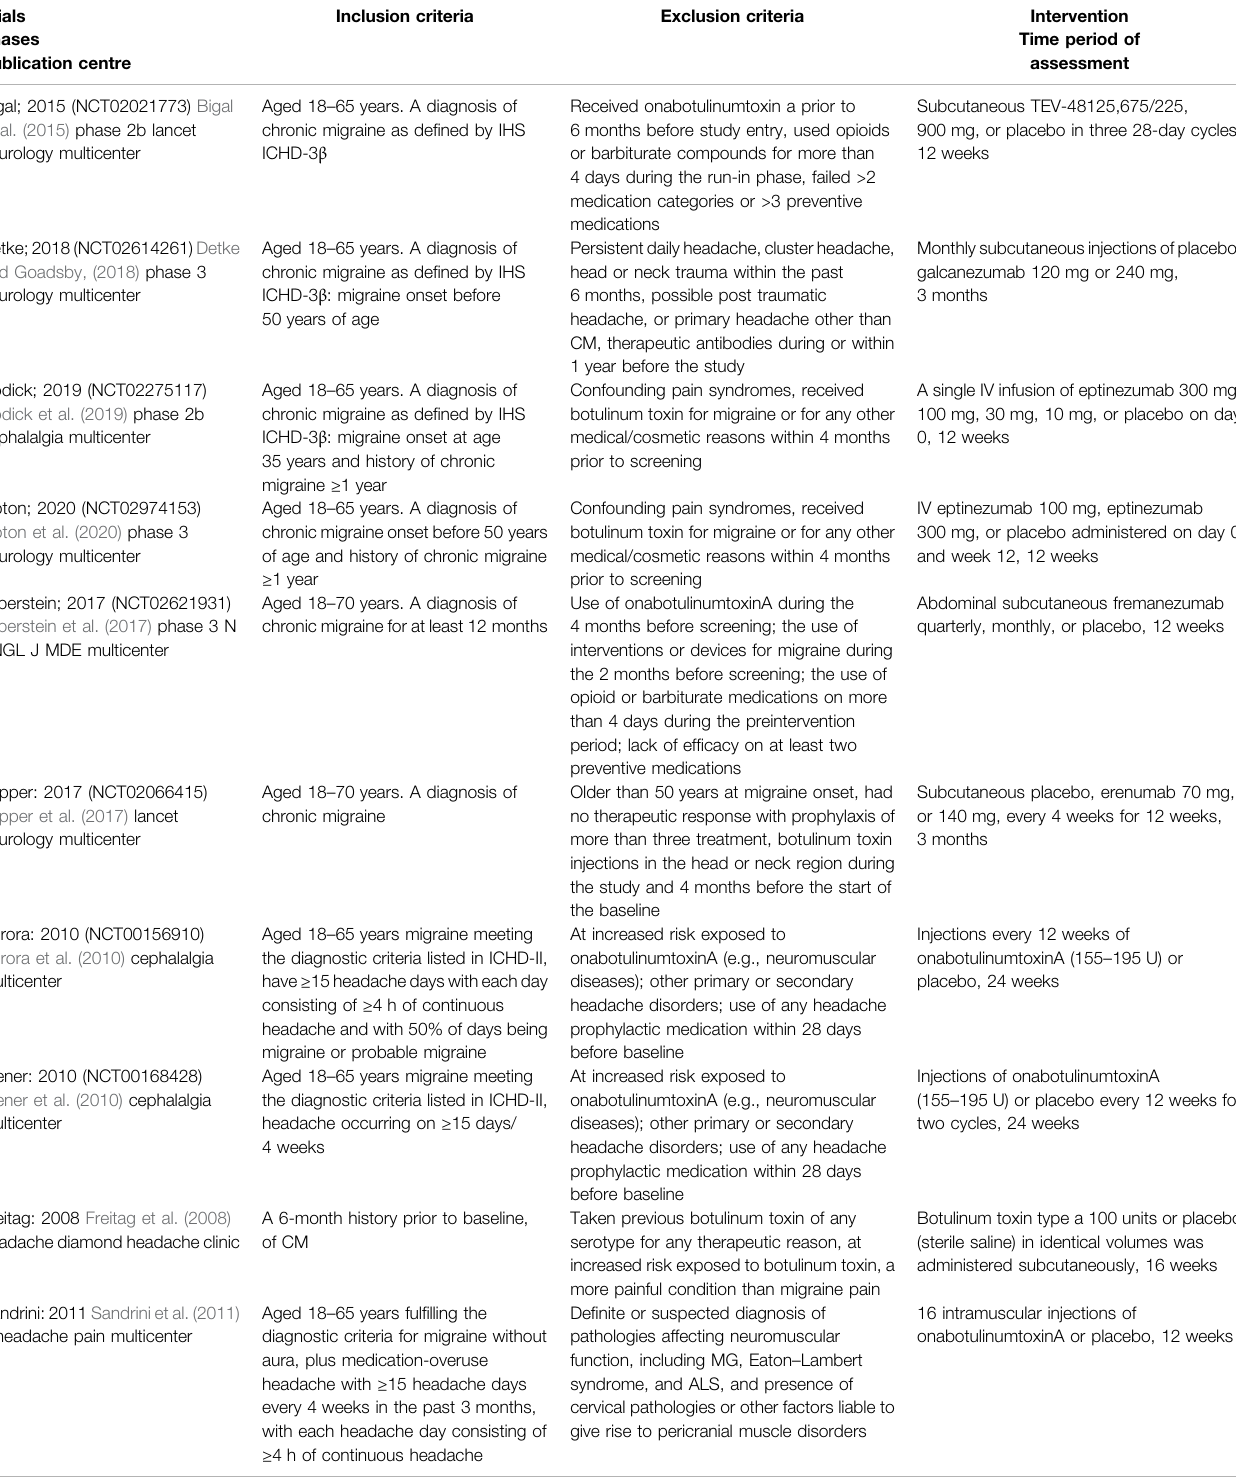
TABLE 1 | Characteristics of the included